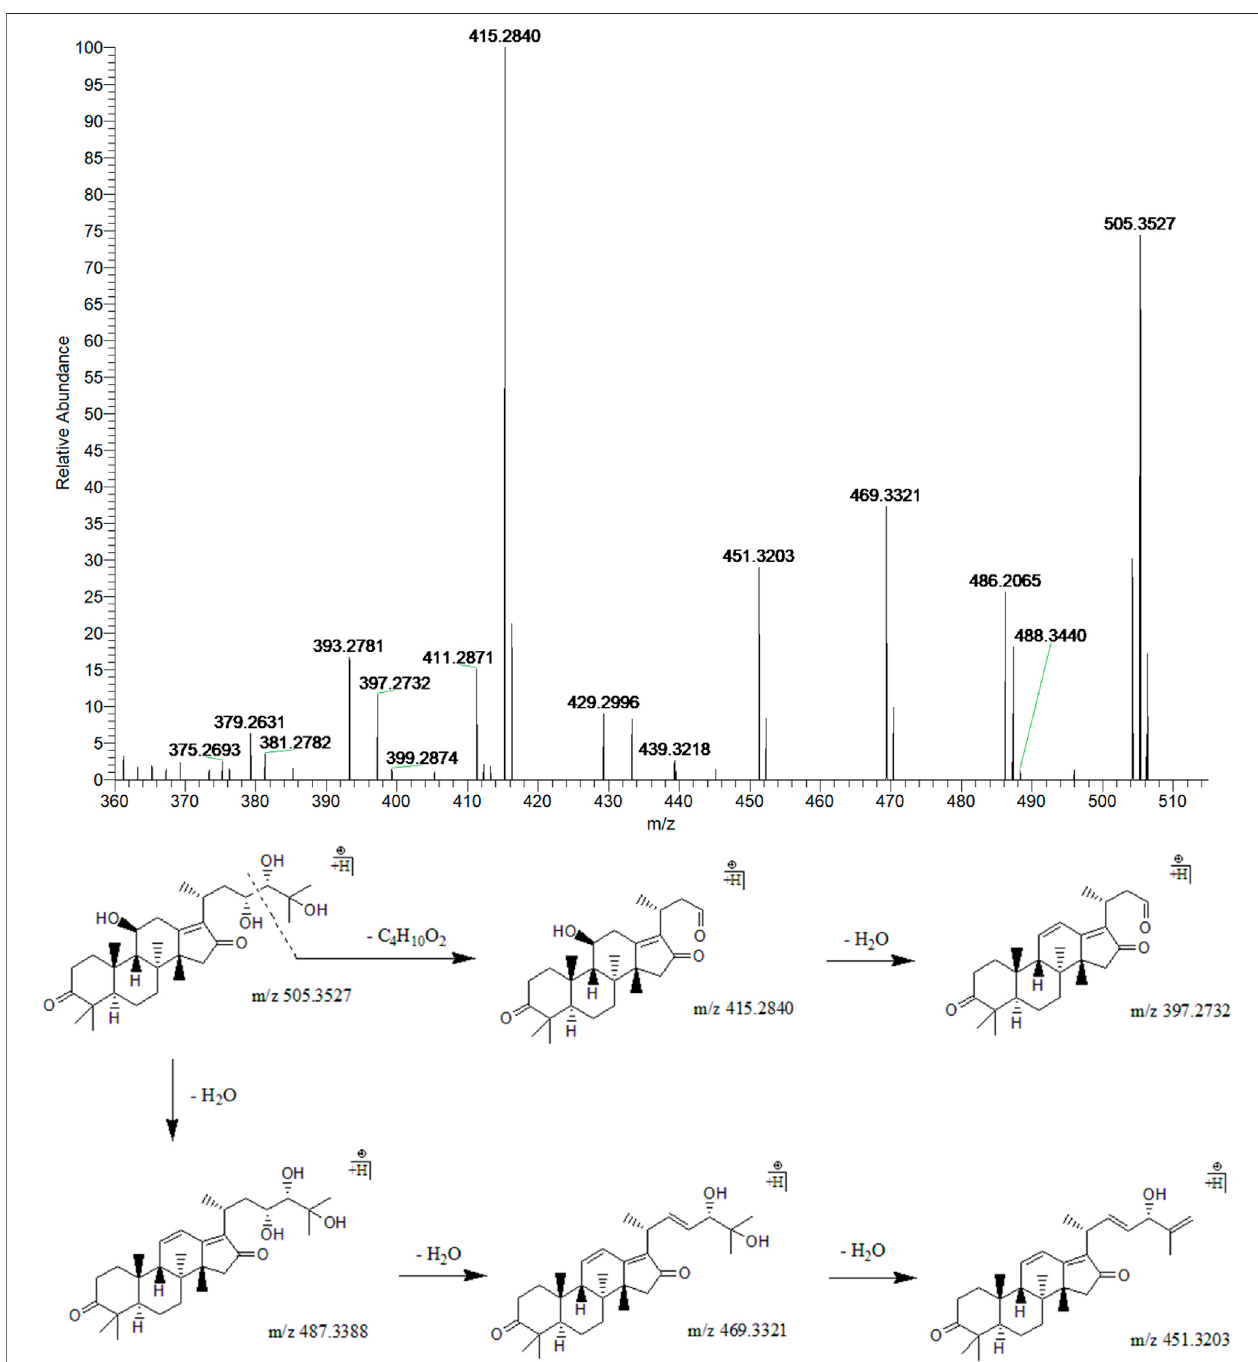
FIGURE 3 | The second-order mass spectrometry graphs and proposed fragmentation pathways of 16-oxo-alisol A (peak 10).